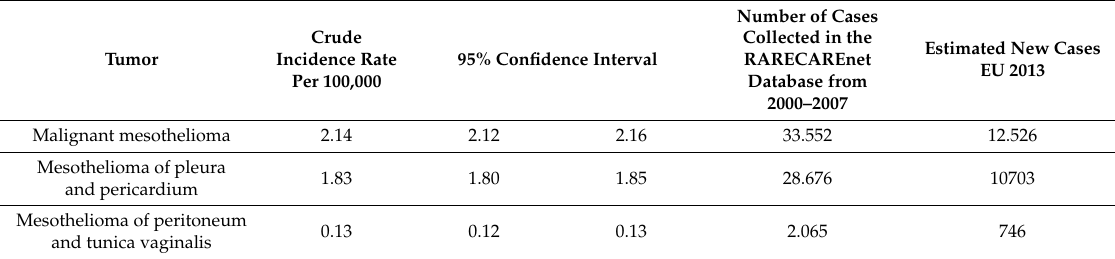
Table 4. RARECARE incidence of malignant mesothelioma (MM)